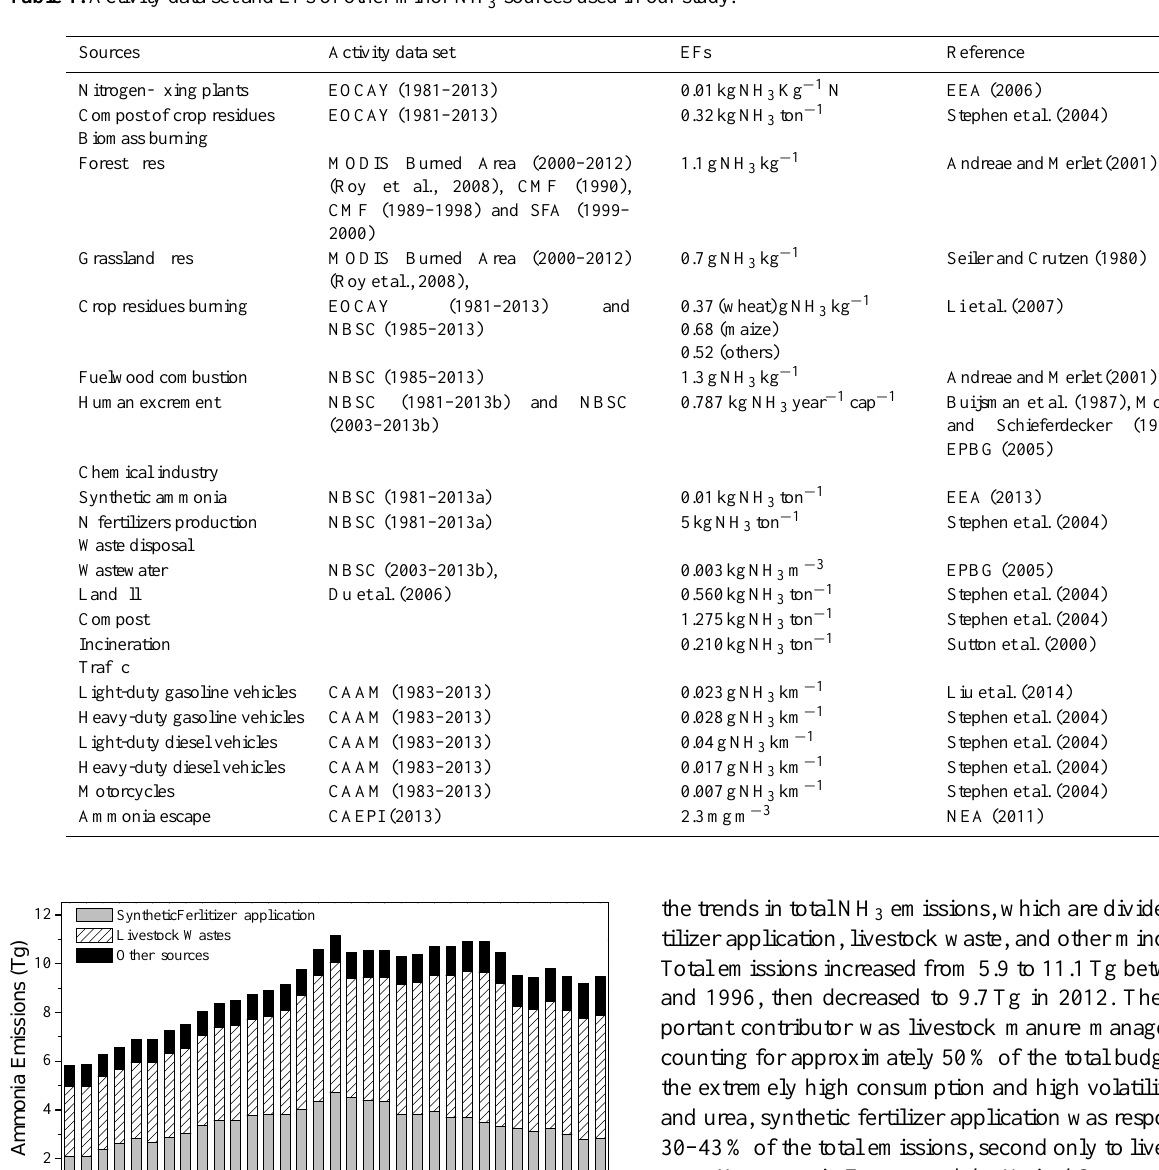
Table 1. Activity data set and EFs of other minor NH 3 sources used in our study.